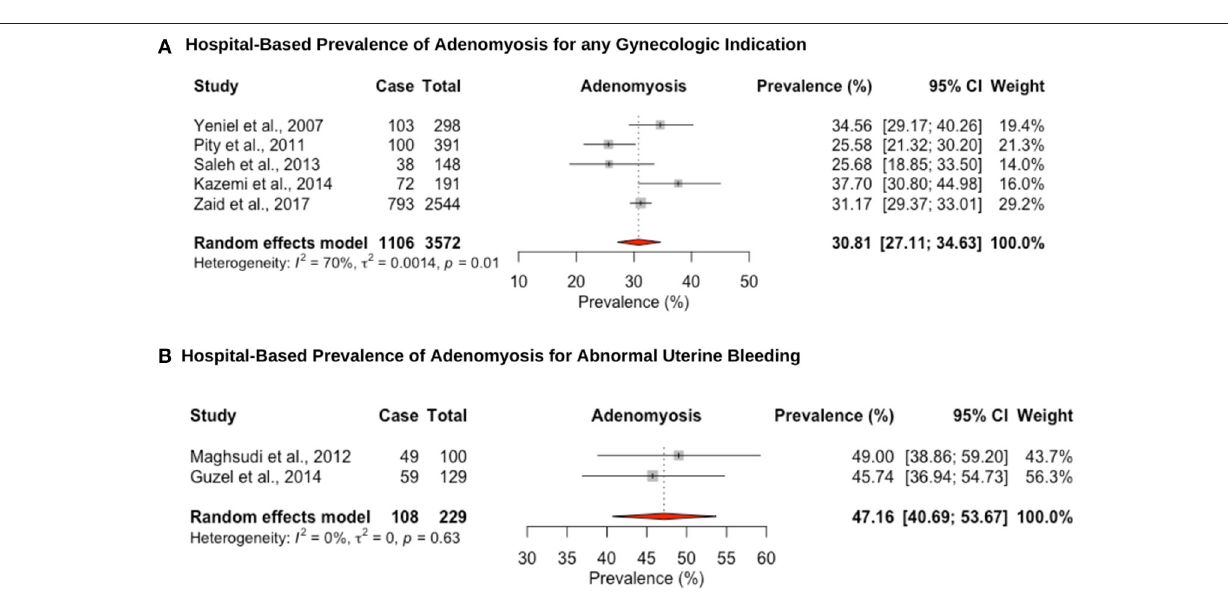
result from different combinations of SNPs more commonly present in women of Middle Eastern origin. This may be a basis for the higher prevalence of PCOS that is dominated by obesity, high blood pressure, diabetes mellitus, and hirsutism (121, 122). Genetic influences in populations of diverse origin are important to study alongside environmental influences, to understand the effect of their interaction in causing different